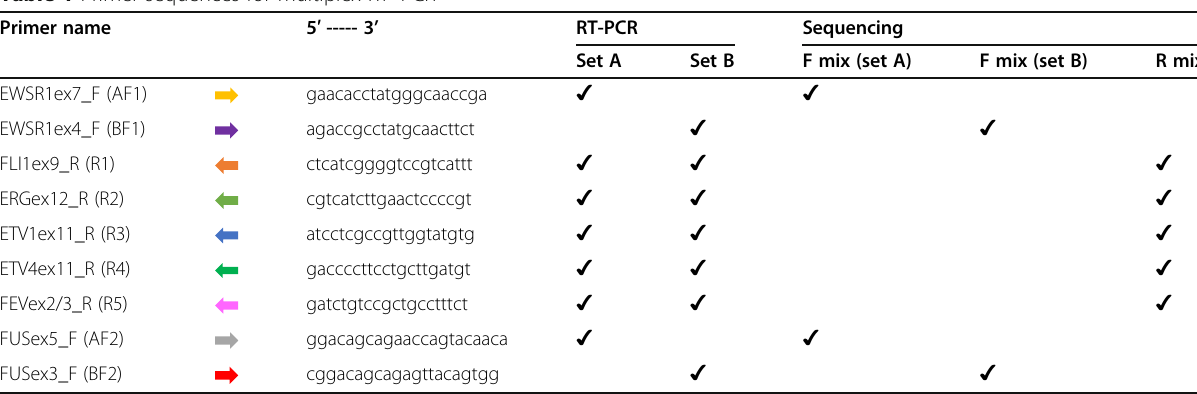
Table 1 Primer sequences for multiplex RT –